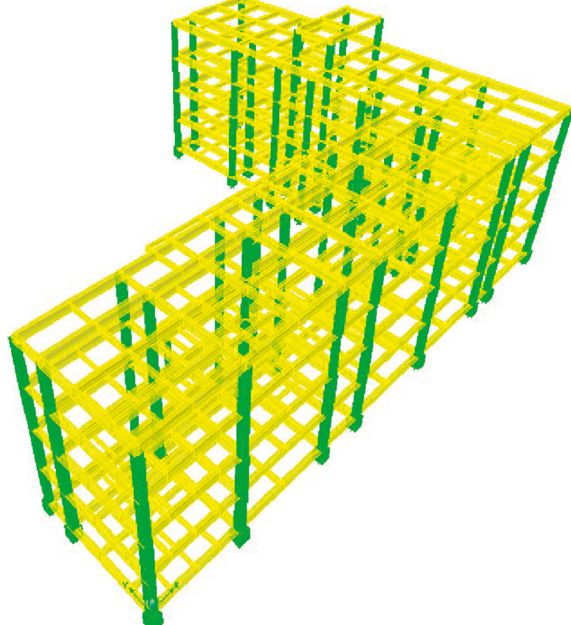
Figure 34: Floor model